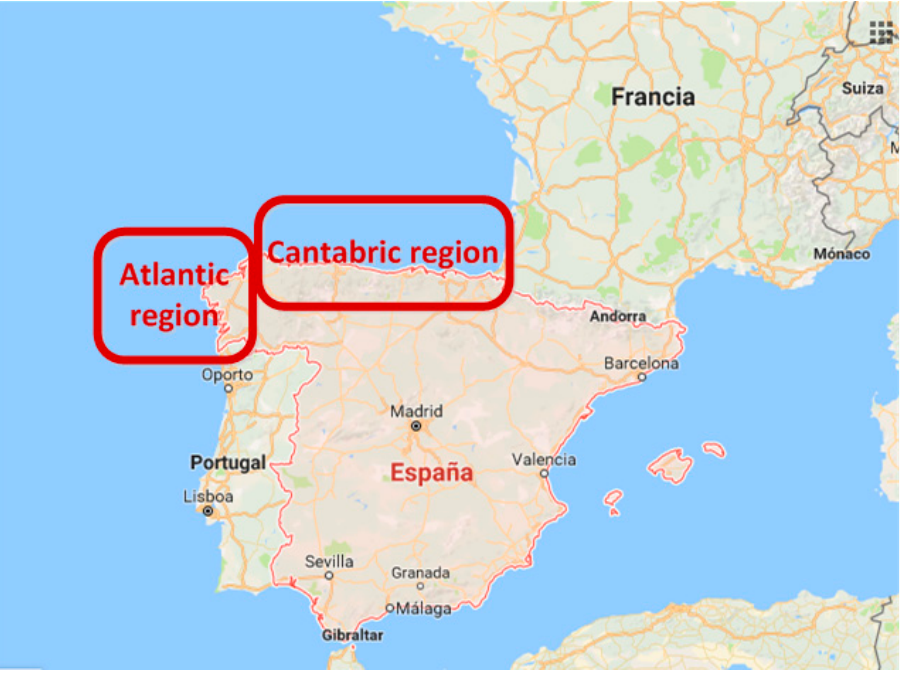
Figure 3. Spanish area selected.